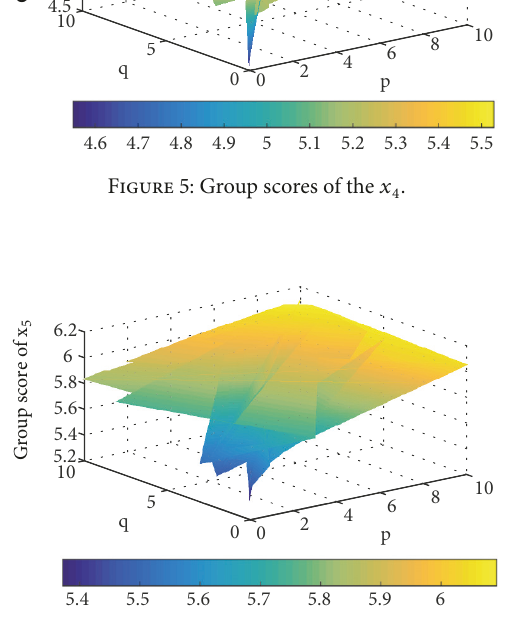
Figure 6: Group scores of the 𝑥 5 .